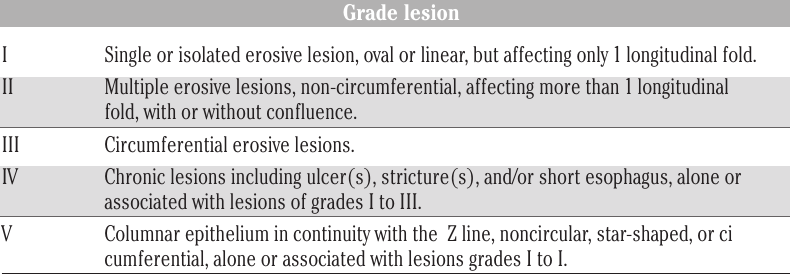
Table 2. Savary Miller classification.